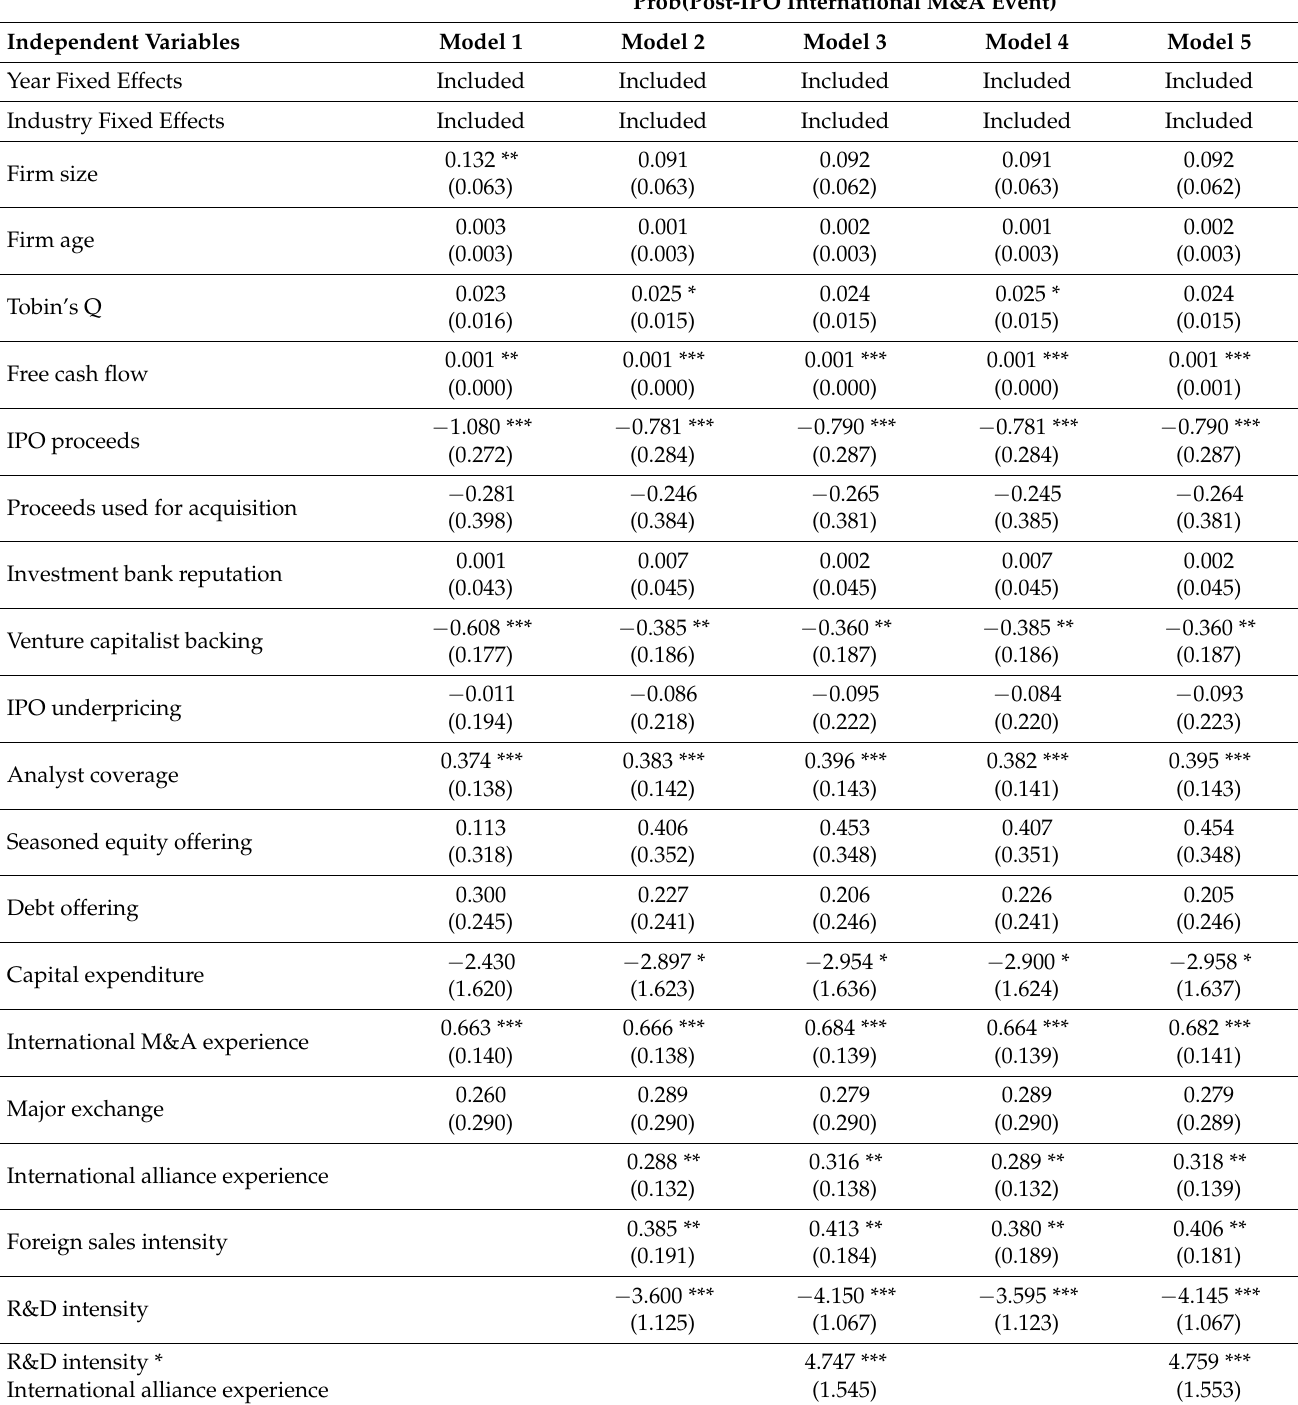
Table 2. Cox Regression Results for Post-IPO International